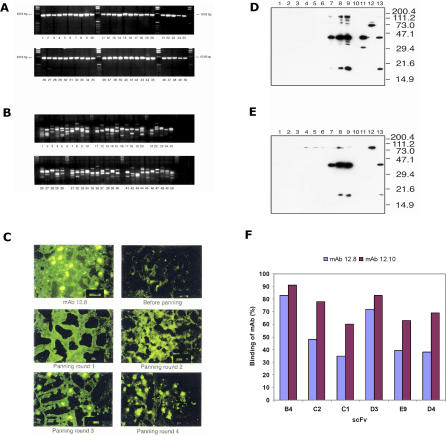
Characterization of scFvs Derived from Phage LibrariesEstimation of diversity of library scFv inserts by BstNI digestion. Figure shows restriction digest patterns of 50 randomly selected scFvs from the October library.(A) 50 inserts of the VH–VK scFvs amplified by PCR screen from 50 randomly selected colonies.(B) The same VH–VK scFv inserts after digestion with BstNI. A large number of different digestion patterns are seen, suggesting a high degree of diversity among the library.(C–E) Binding of polyclonal scFv from panning rounds 1–4 to P. falciparum by IFA [20]. IFA was carried out using acetone-fixed parasites, and the polyclonal scFv tested against the T9–96 and FCB-1 strains of P. falciparum at 20 μg/ml [20]. MAb 12.8 was used as a positive control and polyclonal scFv prepared from the unpanned libraries used as negative controls. Immunoblots of polyclonal scFv from fourth round of panning binding to P. falciparum strain T9/96 (D) or FCB-1 (E) merozoites [20]. Lane 1, scFv March library unpanned; lane 2, scFv October library unpanned; lane 3–6, scFv from fourth round of panning with unprocessed merozoites; lane 7–8, scFv from fourth round of panning with processed merozoites; lane 9, scFv from fourth round of panning with recombinant MSP119-GST; lane 10, scFv D1.3 (anti-hen's egg lysozyme); lane 11, scFv X509 (anti-MSP133); lane 12, scFv 89.1 (anti-MSP183); lane 13, mAb 12.8 (anti-MSP142 and MSP119).(F) Inhibition of binding of mAbs 12.8 and 12.10 to MSP119 by scFvs derived from the fourth round of panning by competition ELISA [20].